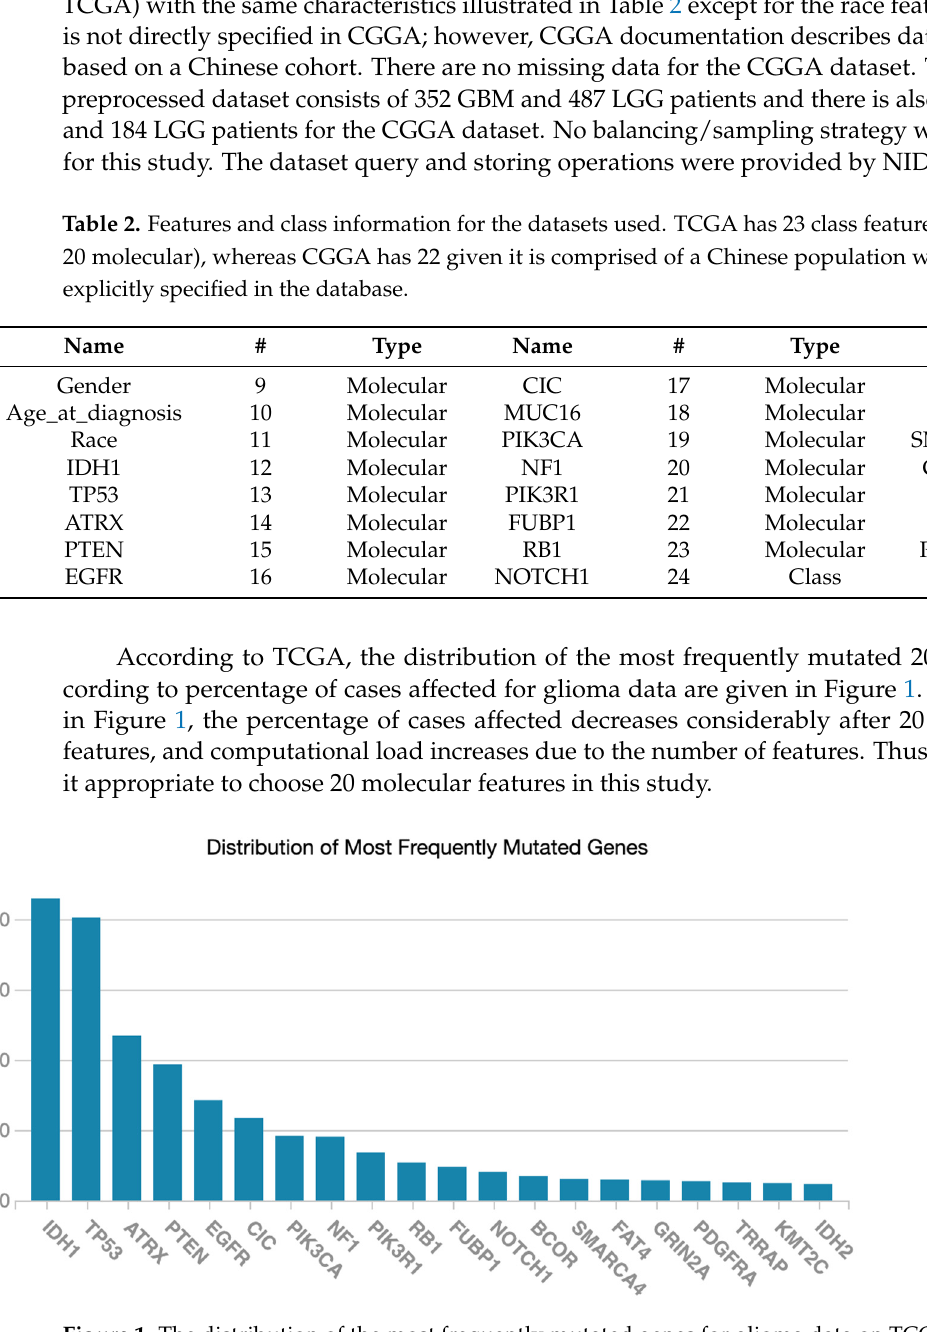
Figure 1. The distribution of the most frequently mutated genes for glioma data on TCGA .